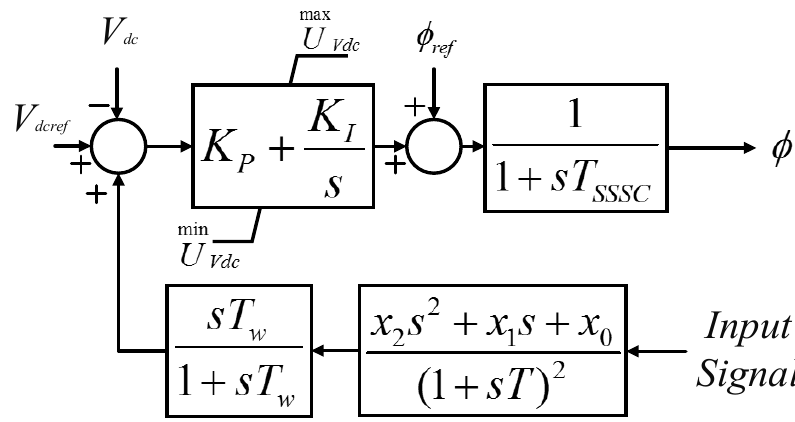
Figure 5. SSSC phase controller with a damping stabilizer.